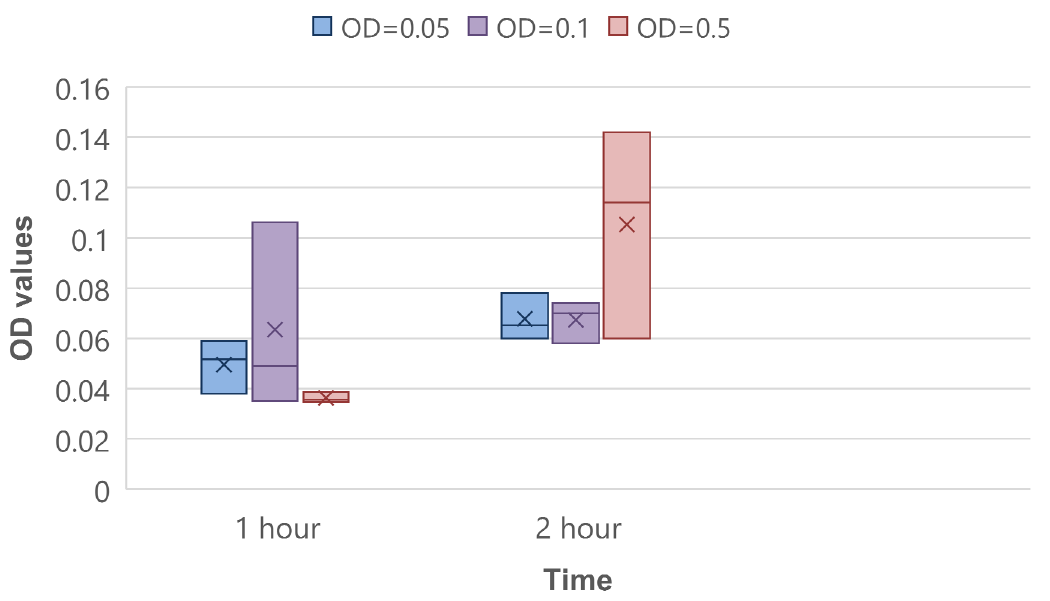
Figure 7. CV binding assay for 1 and 2 h of bacteria incubation.